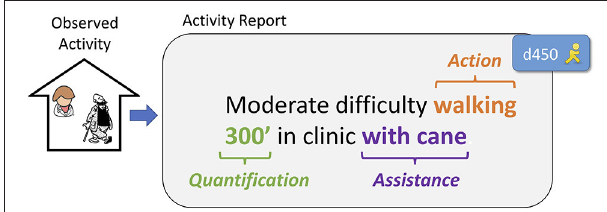
FIGURE 1 | An example activity report describing a clinical observation of mobility, indicating: (i) the Action being described, (ii) a source of Assistance involved in activity performance, and (iii) the Quantification outcome of the measurement setting. The Action in this activity report is assigned ICF code d450 Walking .